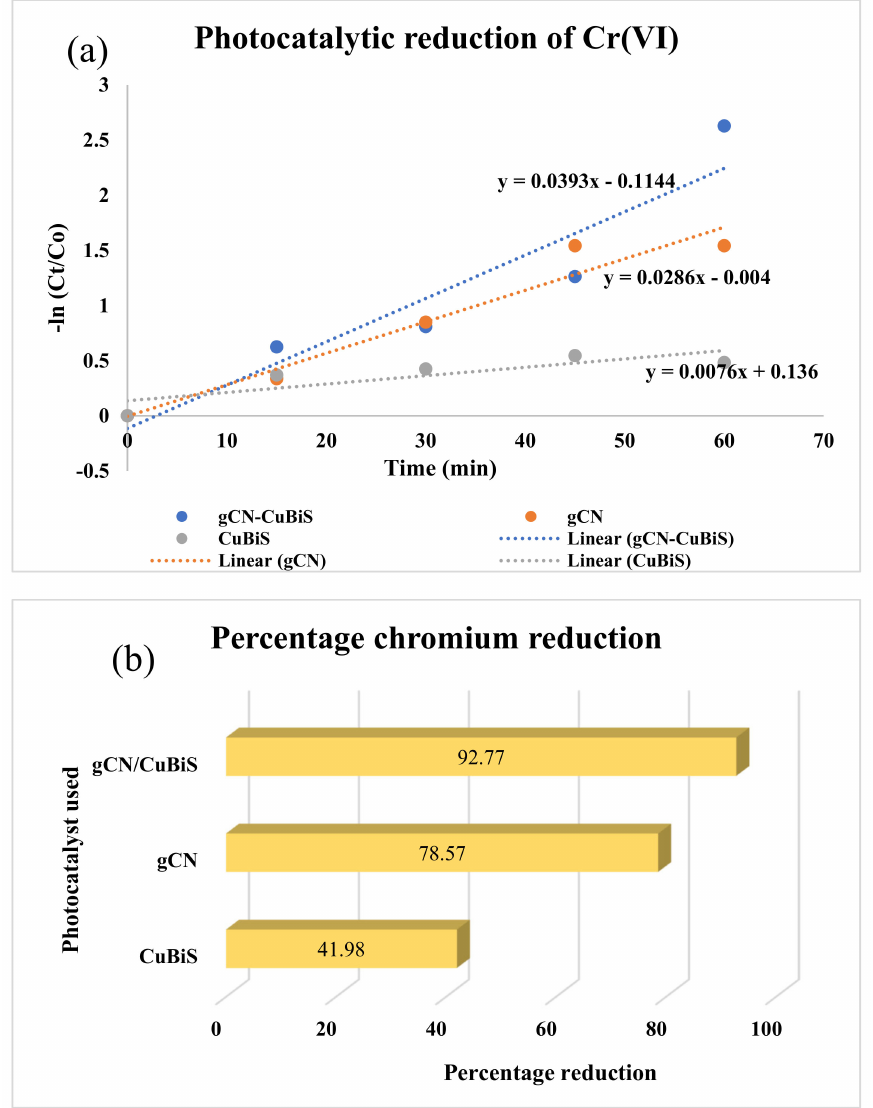
Figure 8. The ( a ) Pseudo-first-order rate and ( b ) percentage of photocatalytic reduction of Cr(VI) using pristine Cu 3.21 Bi 4.79 S 9 , graphitic carbon nitride, and their